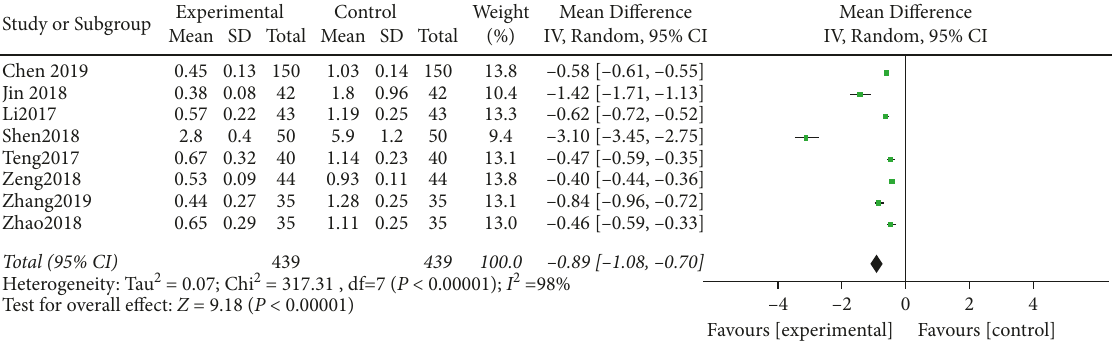
Figure 5: FL score after treatment.